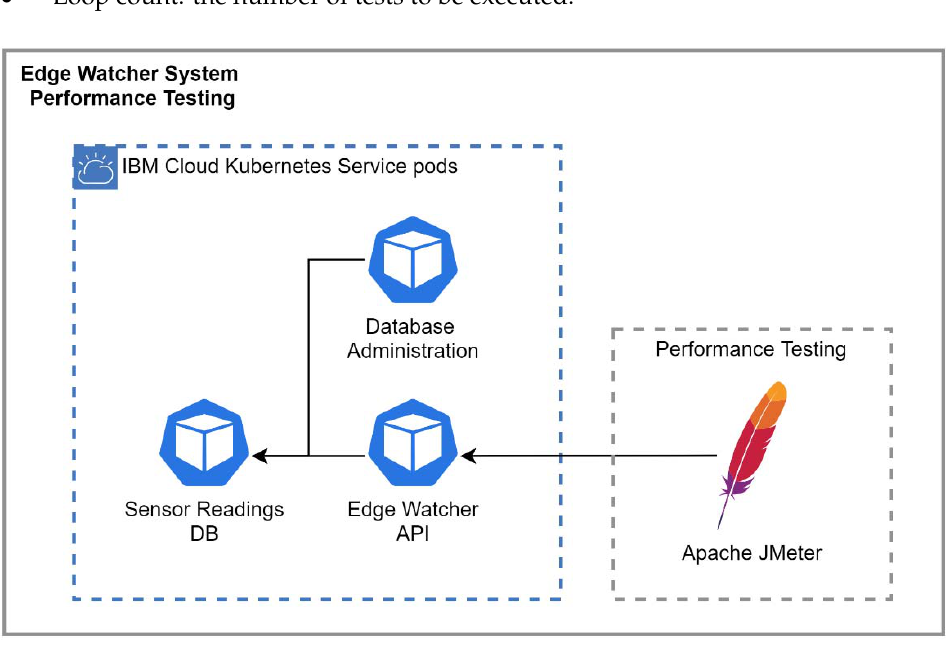
Figure 5. Performance testing architecture.